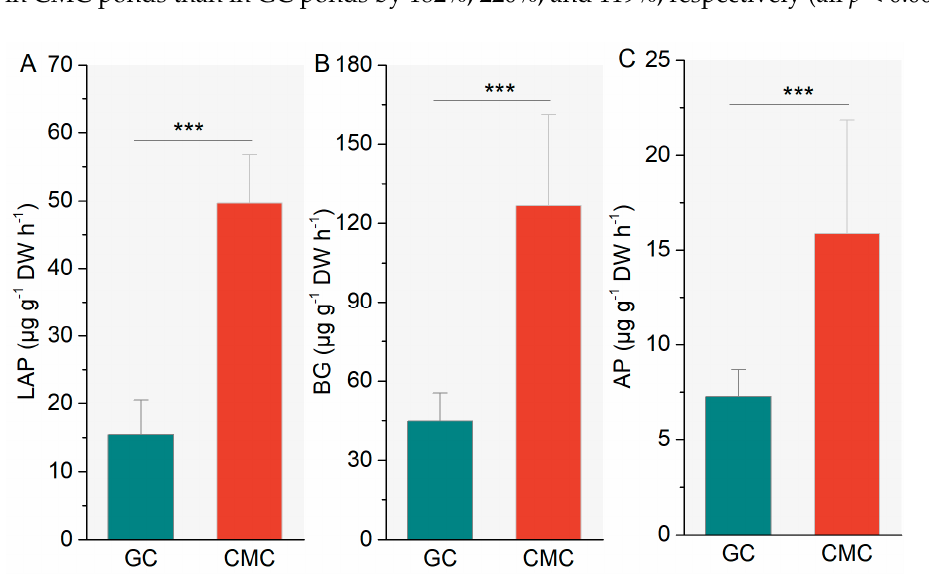
Figure 2. Sediment hydrolytic enzyme activities in ponds with different aquaculture practices. Values are mean ( n = 6) with standard deviation. BG: β -glucosidase; LAP: leucine aminopeptidase; and AP: alkaline phosphatase. See Table 1 and Figure 1 for abbreviations. *** p < 0.001. and ( C ) AP: alkaline phosphatase. See Table 1 and Figure 1 for abbreviations. *** p <